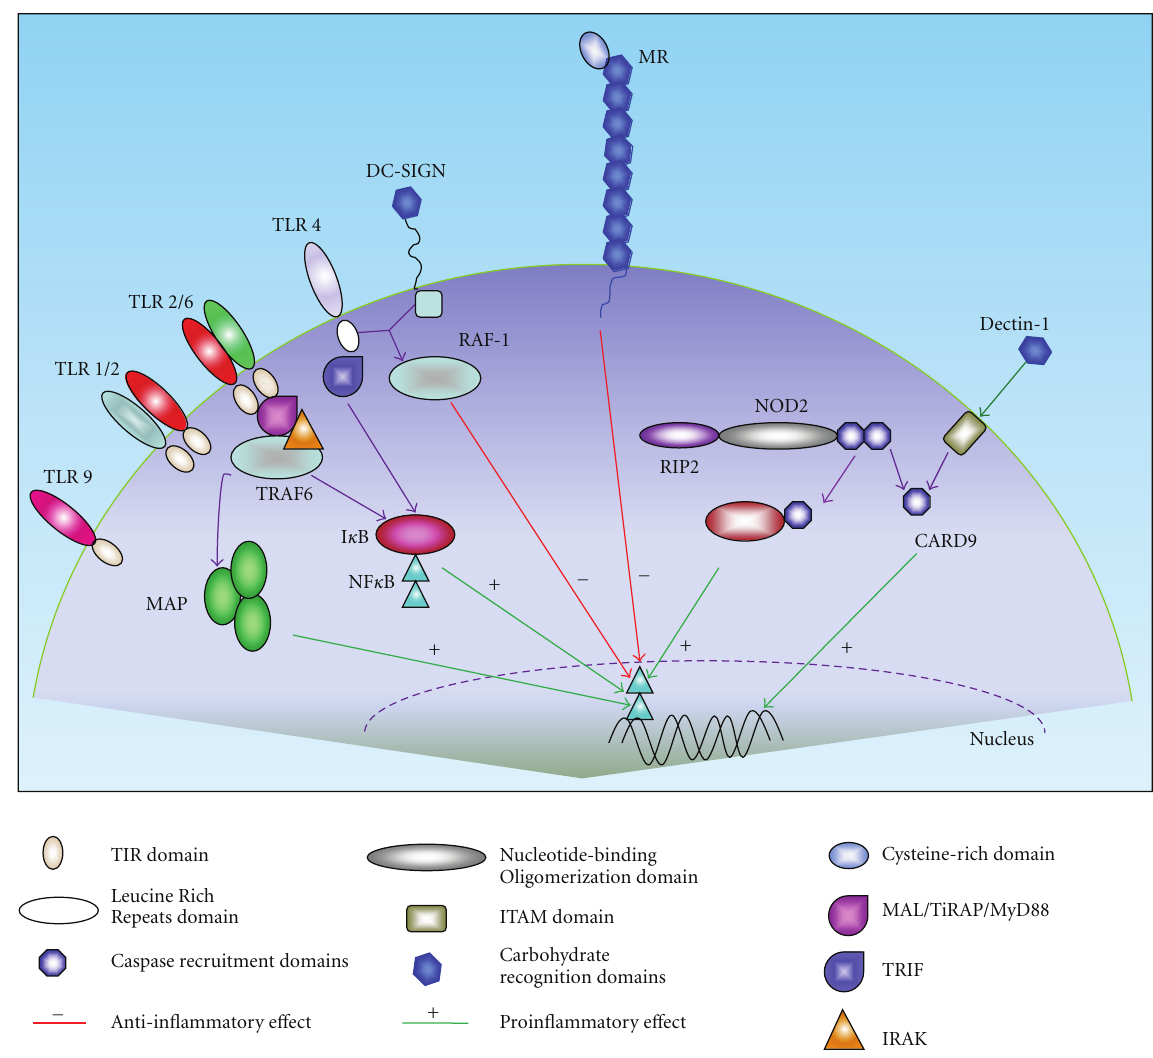
Figure 2: Pattern recognition receptors in the recognition of mycobacteria and downstream signaling pathways. Mycobacteria can be recognized through di ff erent pattern recognition receptors (PRRs) of the host. Both intracellular and extracellular receptors are involved in this process. After recognition of mycobacteria, intracellular signaling cascades are activated which eventually will lead to the activation of transcription of NF- κ B. After transcription, the production of pro- and anti-inflammatory cytokines and chemokines is induced. The type of signaling cascade induced depends mainly on the type of PRR that recognizes (components of) MTB